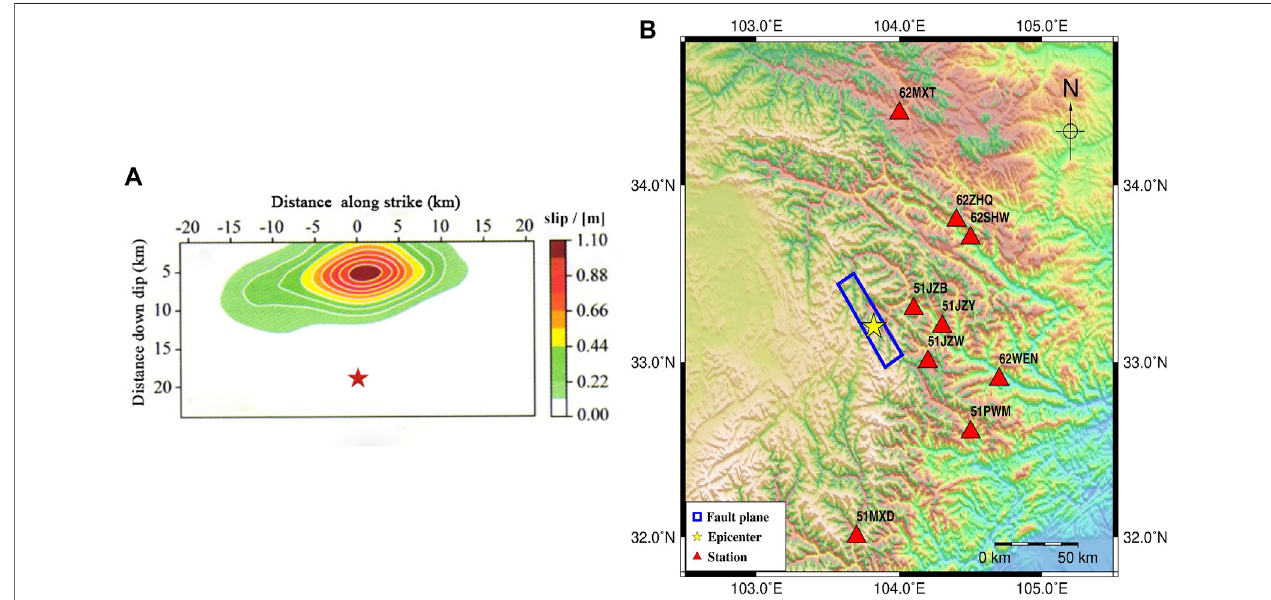
FIGURE1|(A) :SlipdistributionoftheJiuzhaigouearthquake(Zhengetal.,2017)and (B) :locationofthefaultplaneandselectedstrong-motionstations.Theblack triangle indicates the stations triggered by the Jiuzhaigou earthquake, the red rectangle represents the fault plane, and the red pentagram represents the hypocenter.